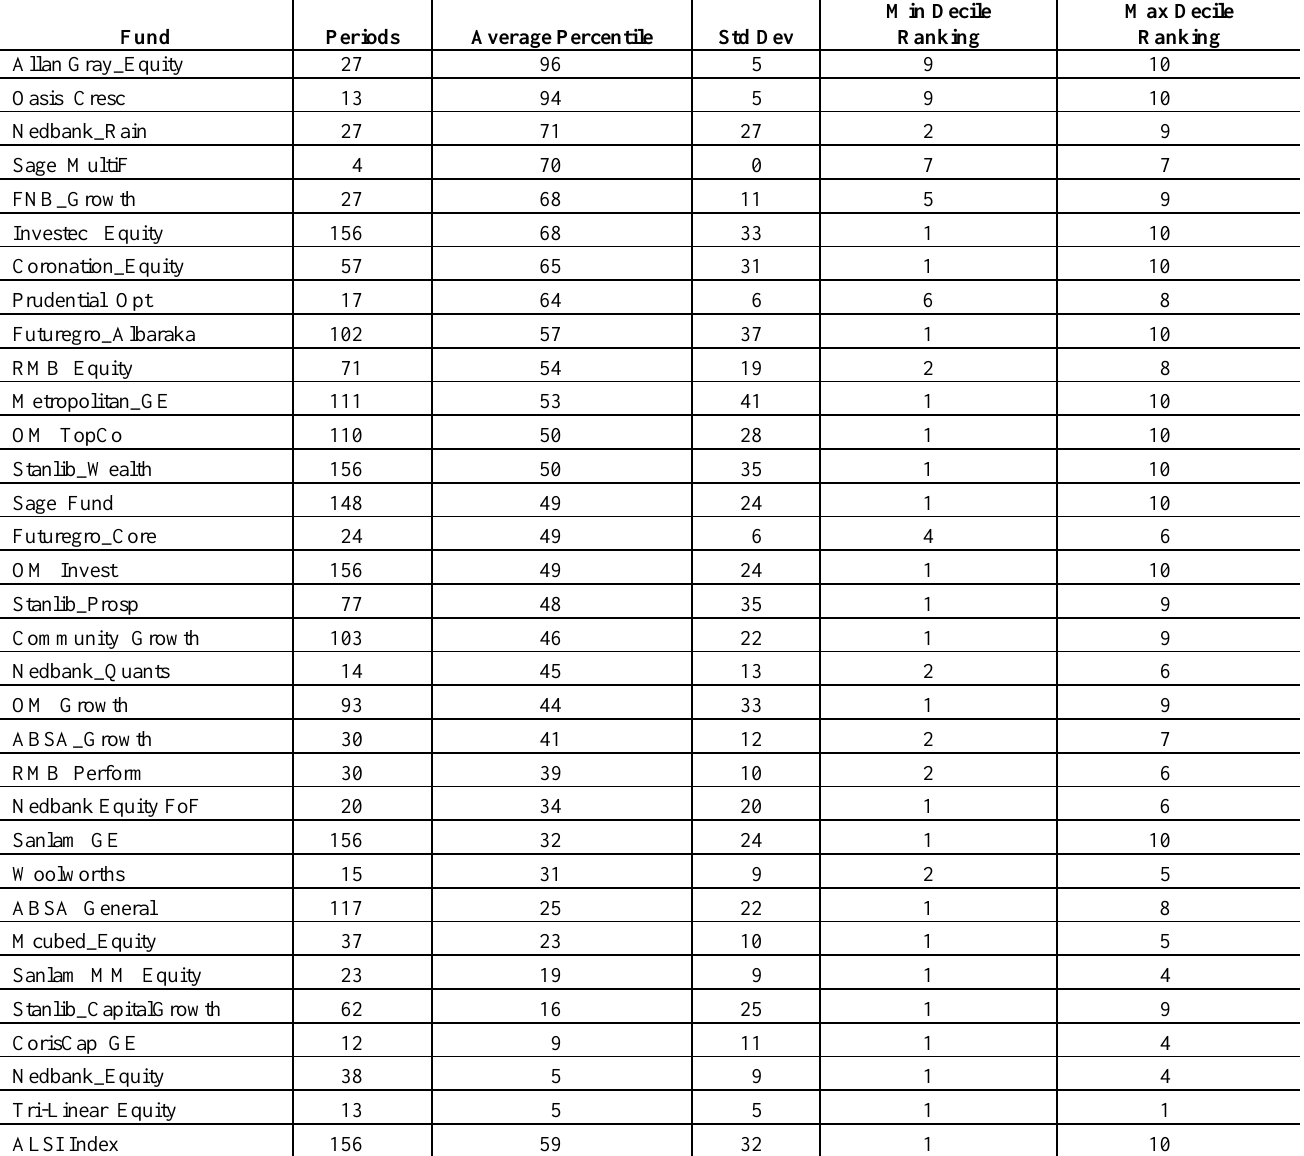
Table 1: Percentile ranking of actively managed funds over rolling 36-month investment periods